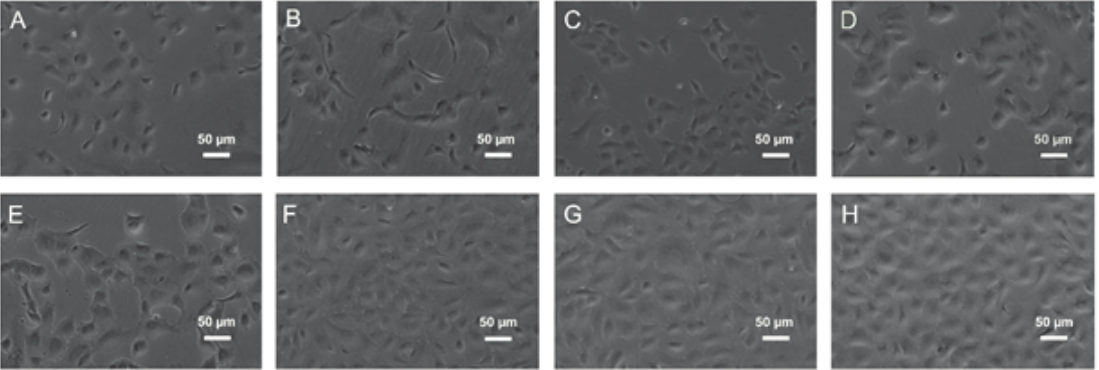
Figure 3. Representative photomicrographs of cultivated HCECs in treated and control groups (A–D) one and (E–H) five days after treatments. The morphology of HCECs after five days of cultures in (E) 20% FBS, (F) 10 μM Y-27632 ROCK inhibitor, (G) combination